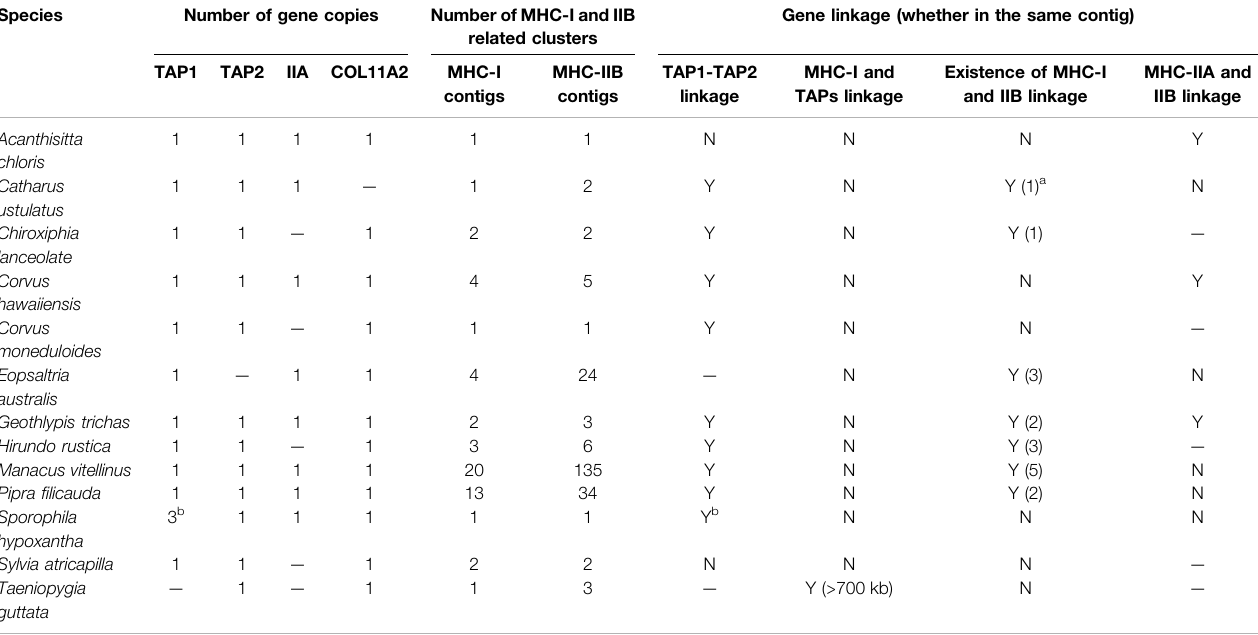
TABLE 2 | Gene numbers, linkage, and gene arrangement of MHC-I and MHC-II genes in passerine birds (TGS-based genomes). Species Number of gene